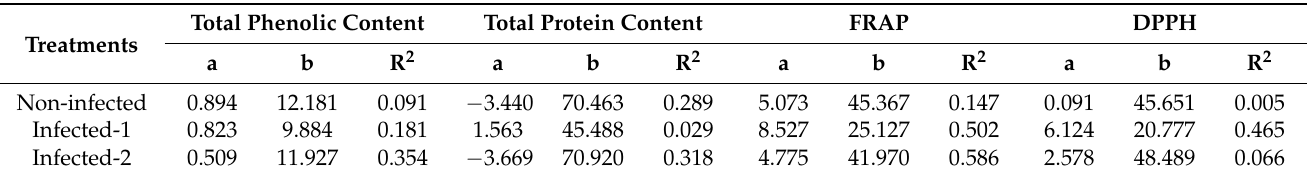
Figure 3. Biochemical measurements of the total phenolic content ( A ), the total protein content ( B ), the ferric-reducing antioxidant power ( C ) and DPPH free radical scavenging activity ( D ) of non-infected, artificial infected with B. cinerea disc (Infected-1) and infected with pathogen spore suspension (Infected-2) of “Little Gem” lettuce after 12, 18, 36, 60, and 84 h of artificial infection. DW—dry weight. Table 4. Coefficients for linear regression equations presented in Figure 3, in the form of y = ax + b, and their correlation coefficients (R 2